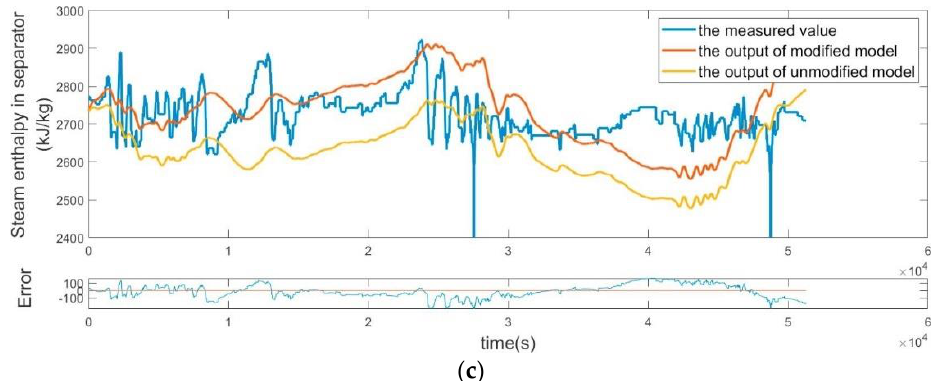
Figure 2. Comparison between measurements (blue line), unmodified (yellow line) and modified model (orange line) for: ( a ) unit load; ( b ) main steam pressure; ( c ) steam enthalpy in separator; Reprint with permission [62]; 2019, Elsevier.